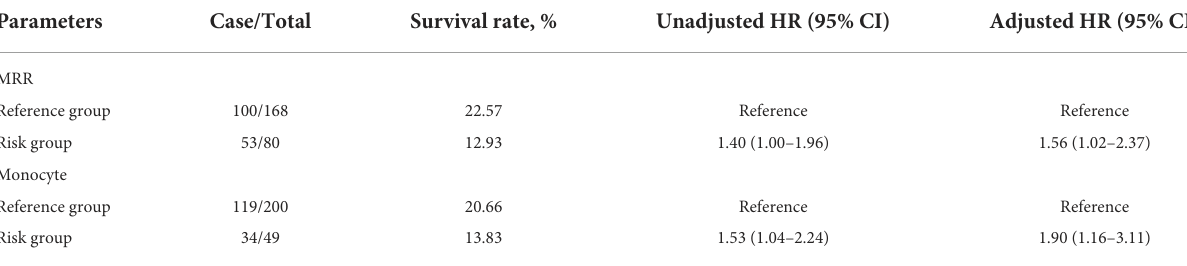
TABLE 3 Effect-size estimates of MRR and monocytes for mortality as categorical variable in the derivation